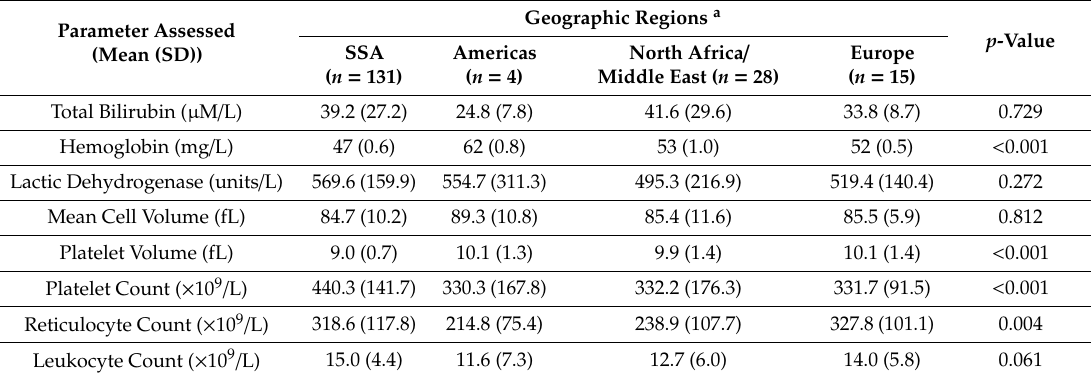
Table 3. Key baseline laboratory values by region for subjects not on